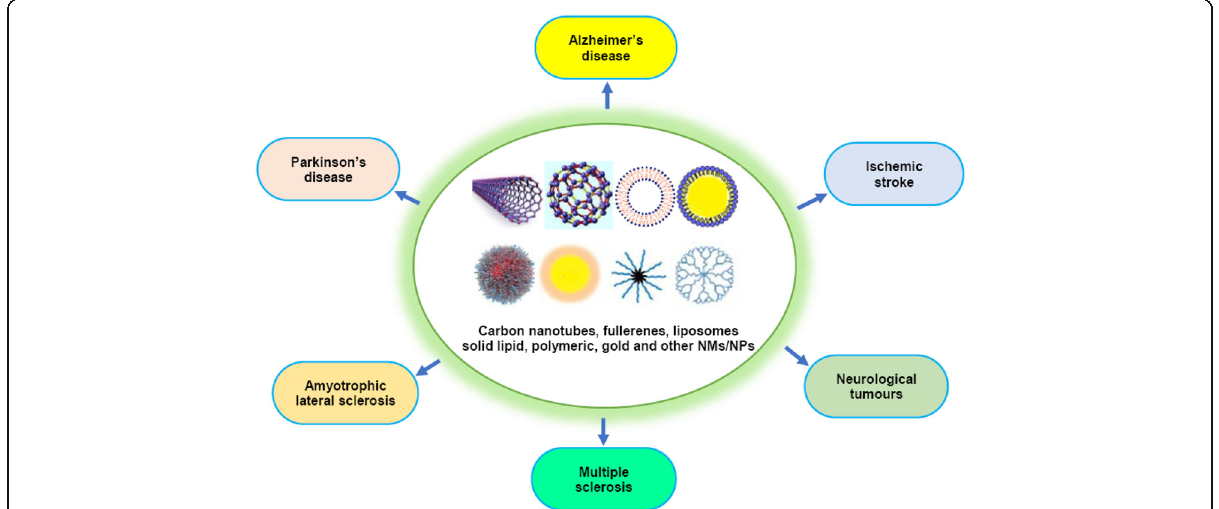
Fig. 1 Different types of NPs and their application in neurological disorder treatment and